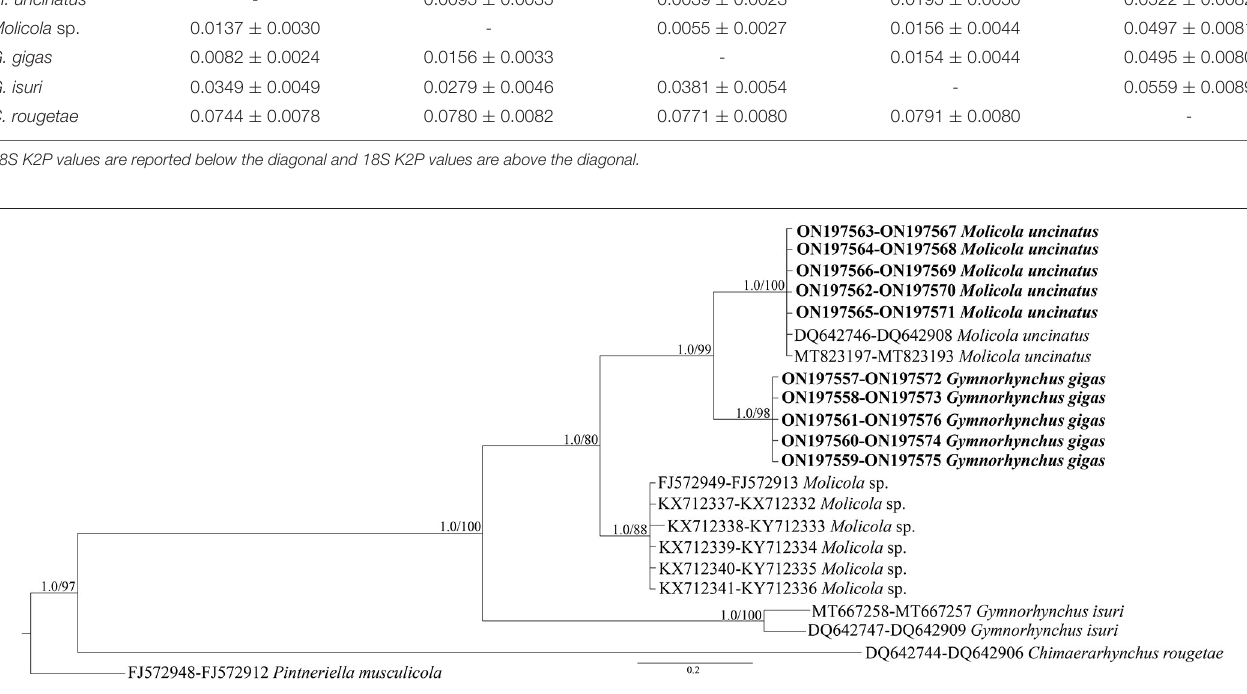
FIGURE 5 | Phylogenetic concatenated tree from maximum likelihood (ML) based on 28S and 18S sequences obtained in the present study (in bold), with respect to the Gymnorhynchidae sequences at the same gene loci available in GenBank. Nodal support is indicated for BI (posterior probabilities) and ML (ultrafast bootstrap), respectively. Pintneriella musculicola was used as